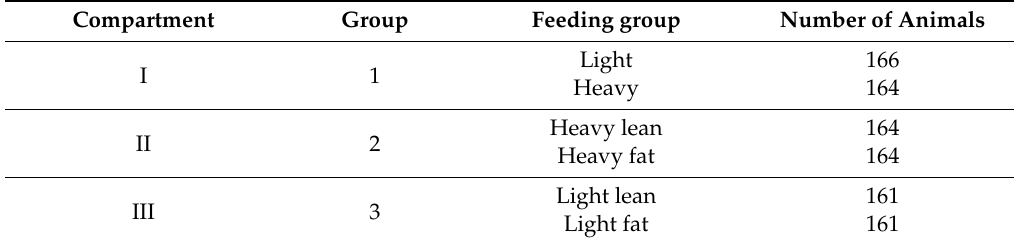
Table 1. Classification of animals into feeding